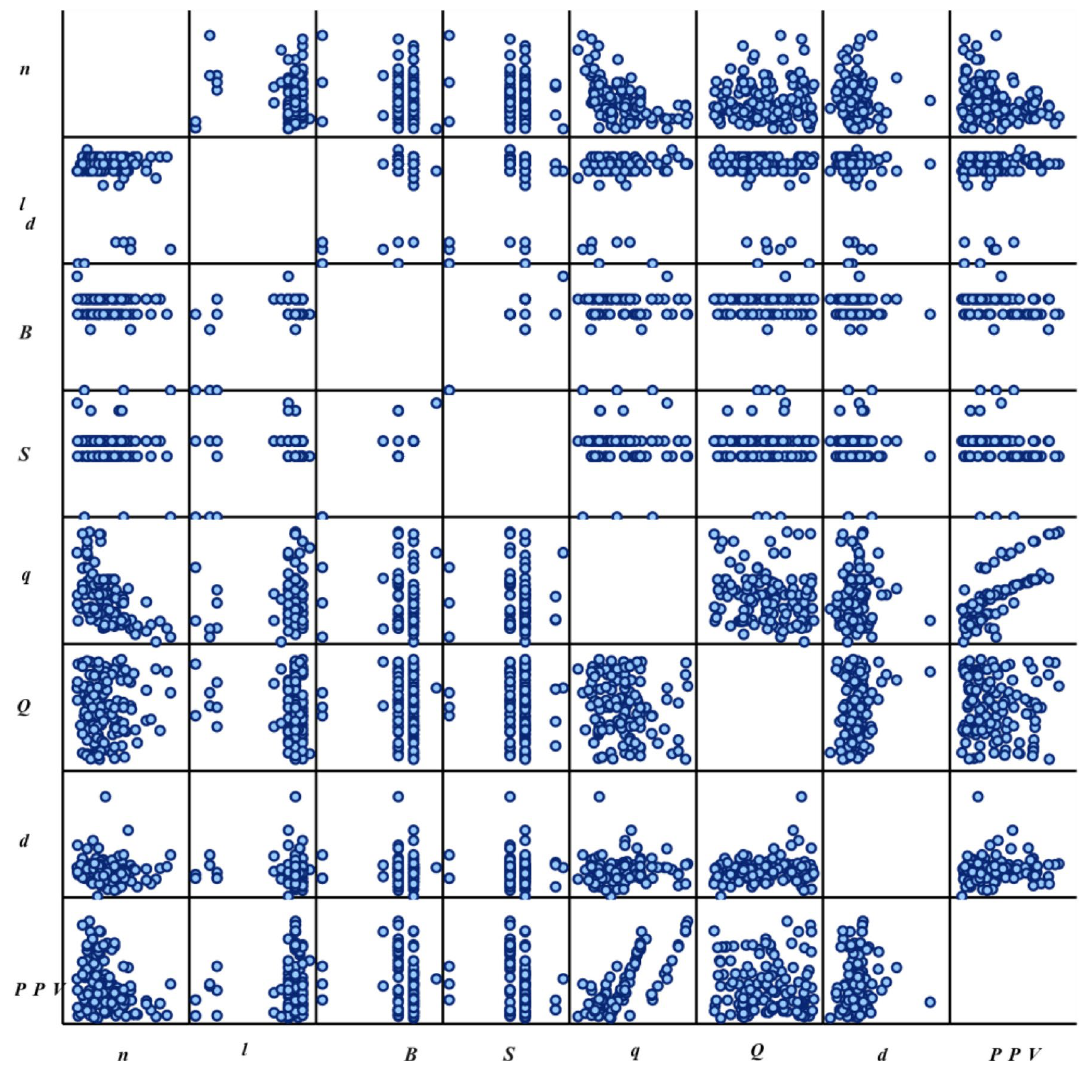
Figure 2. Scatter matrix plot of all parameters considered in this